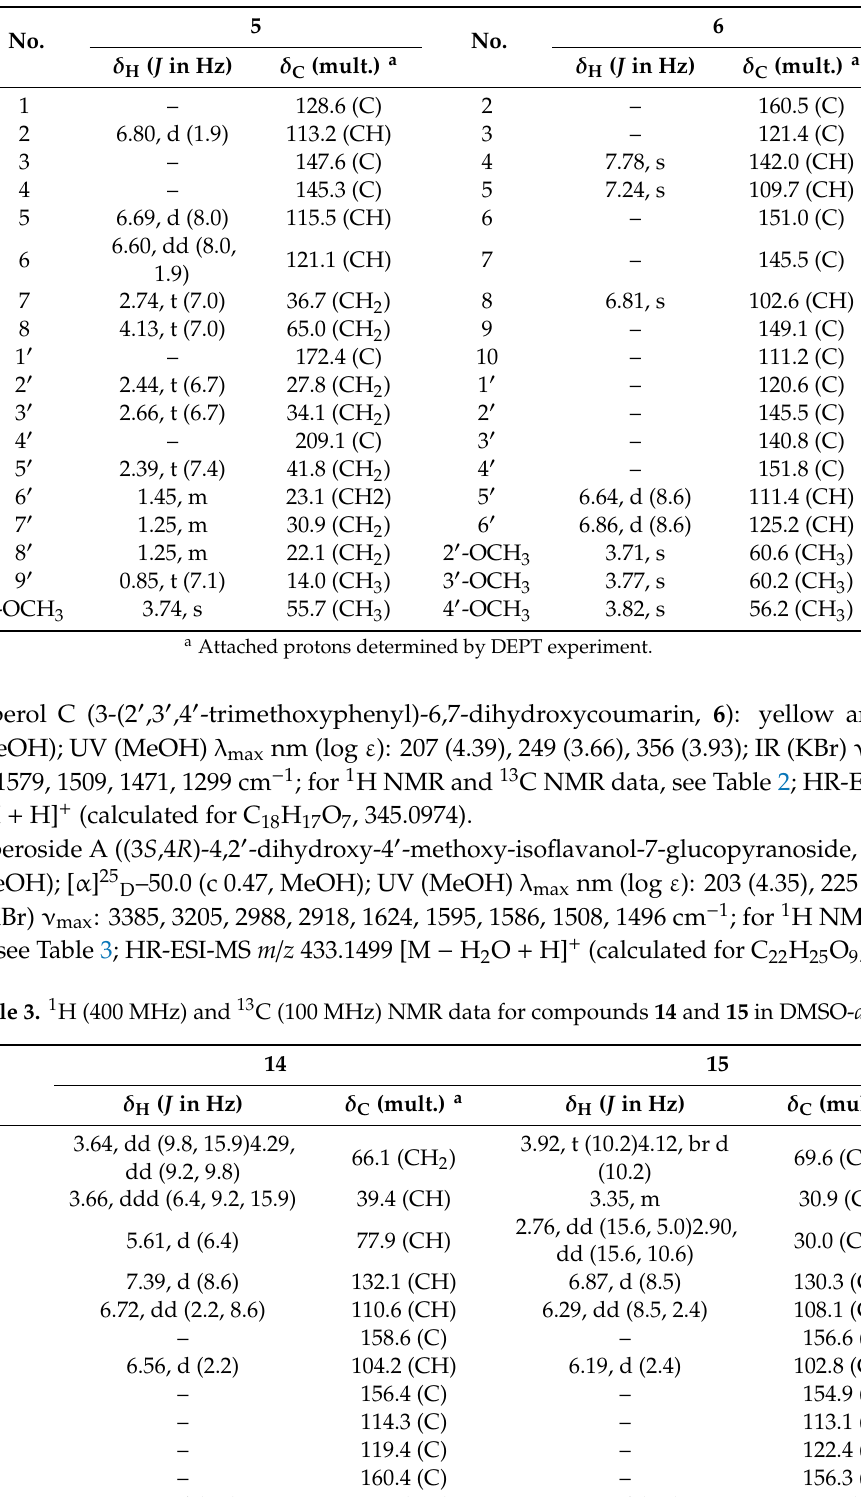
Table 2. 1 H (400 MHz) and 13 C (100 MHz) NMR data for compounds 5 and 6 in DMSO- d 6 .